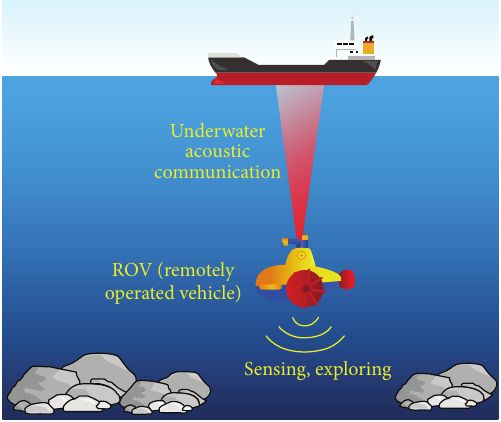
Figure 1: Application of underwater networking.